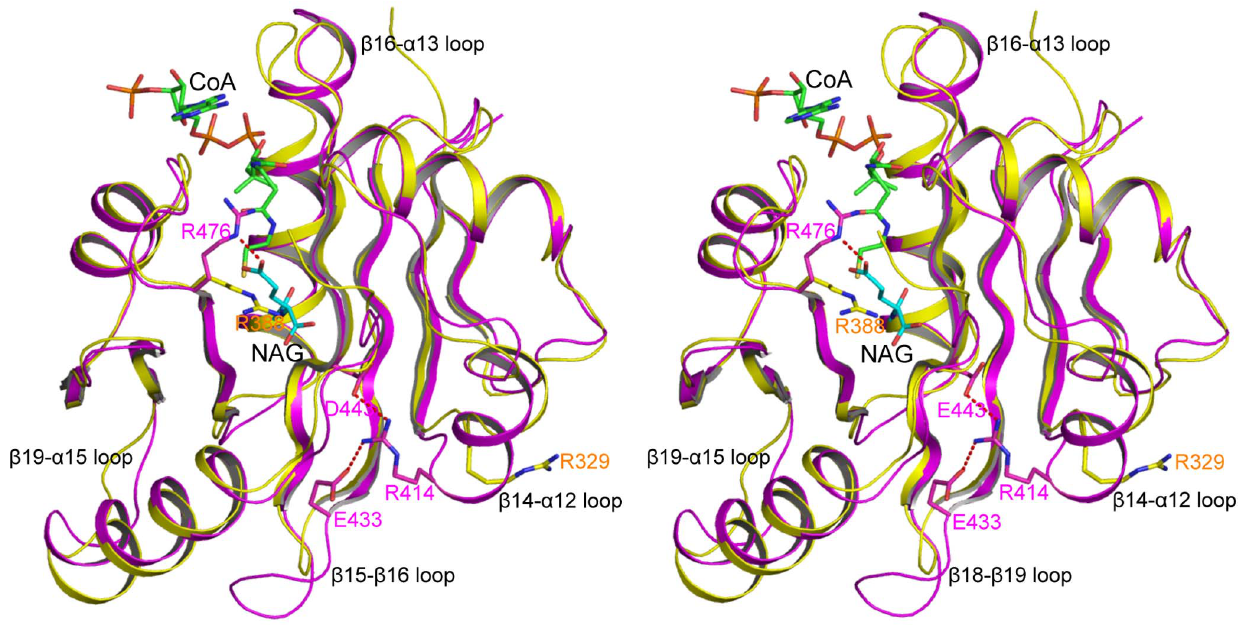
Figure 6. Superimposition of hNAT with the NAT domain of subunit X of mmNAGS/K. The structure of hNAT is shown in pink ribbons. The structure of the NAT domain of subunit X of mmNAGS/K is shown in yellow ribbons. The bound NAG is shown in sky-blue sticks. The proposed bound CoA is shown in green sticks. Residues that are mentioned in text are shown in sticks.